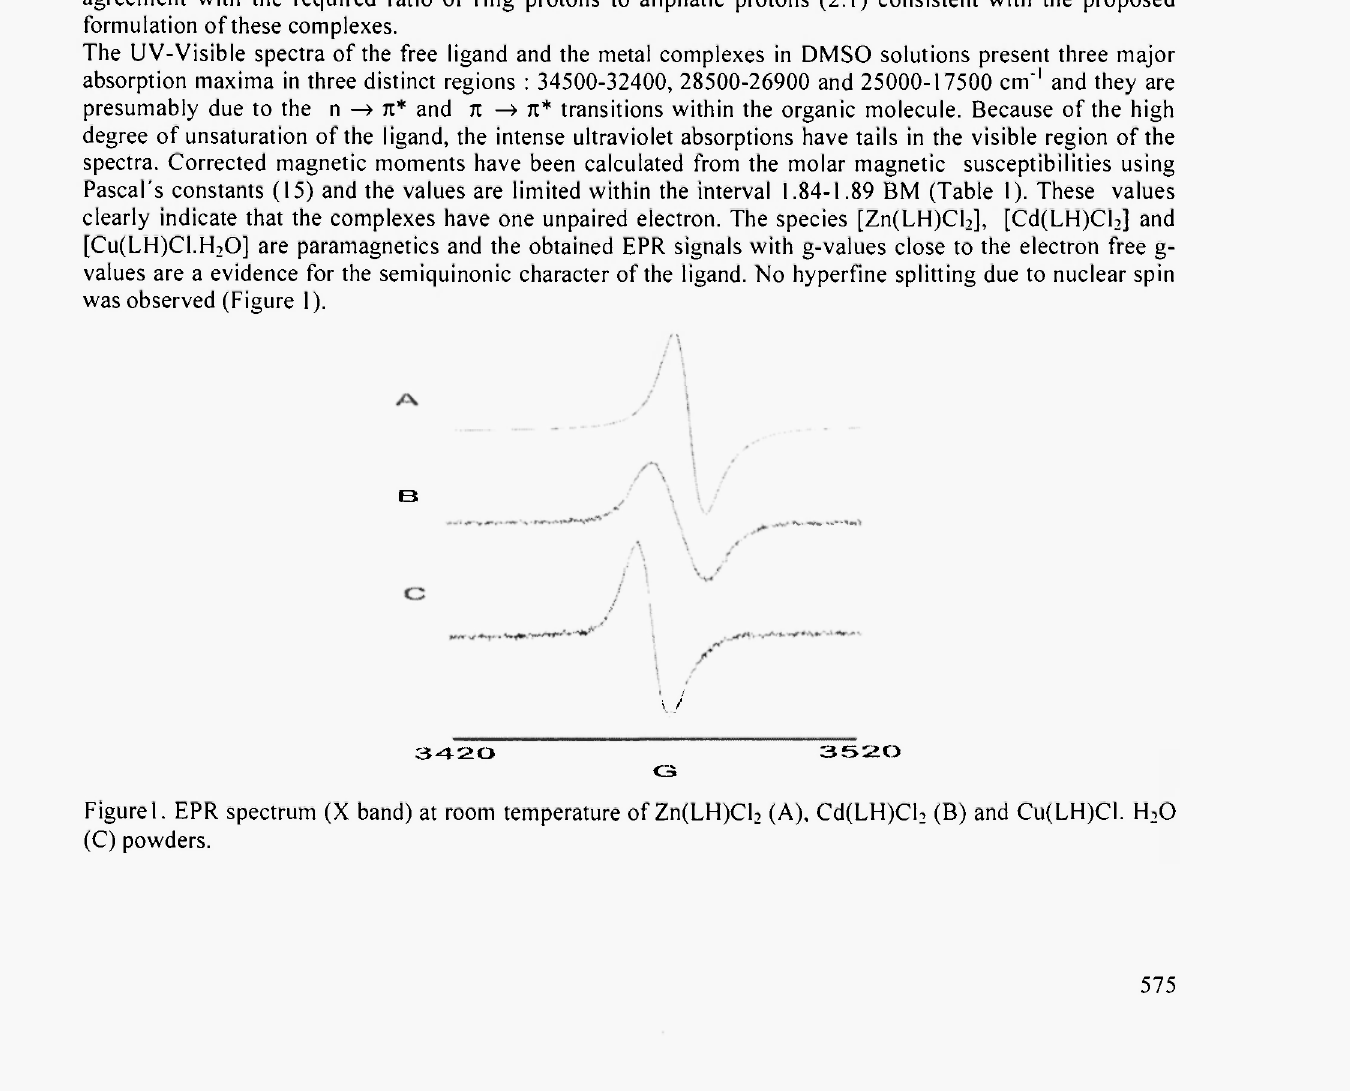
Figure 1. EPR spectrum (X band) at room temperature ofZn(LH)CI 2 (A), Cd(LH)Cl 2 (B) and Cu(LH)Cl. H 2 0 (C)